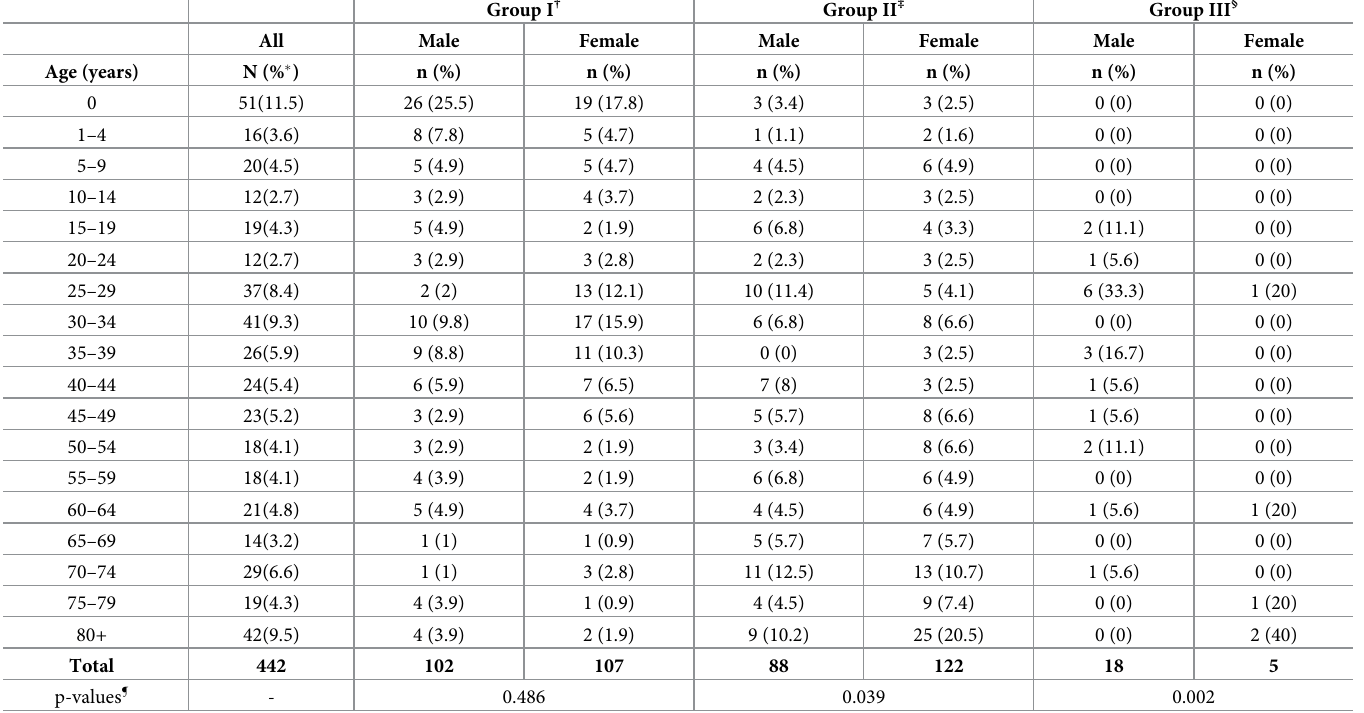
Table 1. Distribution of ascertained causes of death by age and sex, and global burden of disease category from admissions at two large hospitals, Kisumu County, Kenya